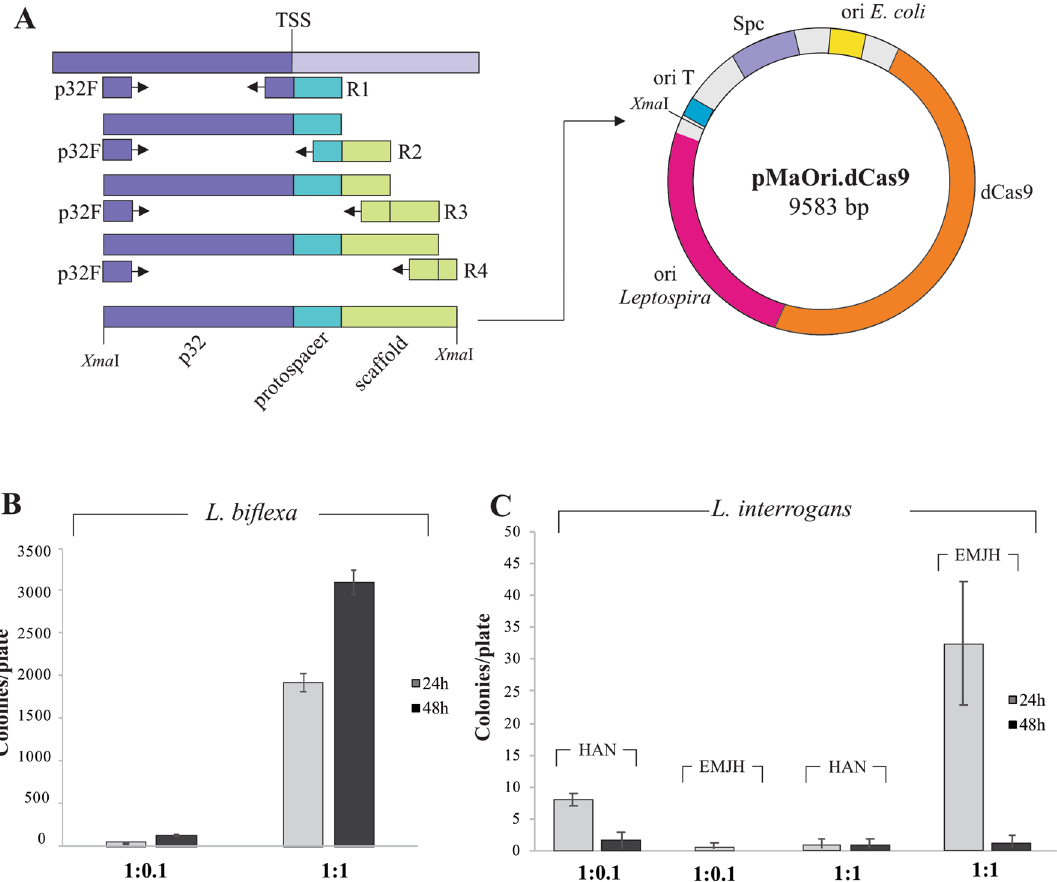
into pMaOri.dCas9 plasmid at Xma I. Plasmid pMaOri.dCas9sg32 (targeting lipL32 CDS) was used to transform the conjugative E. coli β2163, which was concentrated by filtration with recipient wild type L. biflexa ( B ) or L. interrogans ( C ). The recipient:donor proportions of 1:0.1 and 1:1 were employed and filter mating proceeded by either 24 or 48 h. For L. interrogans conjugation, filters were placed onto EMJH or HAN plates plus